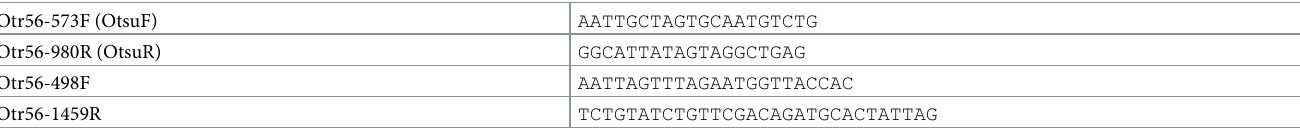
Table 1. Primers for conventional PCR amplification prior to